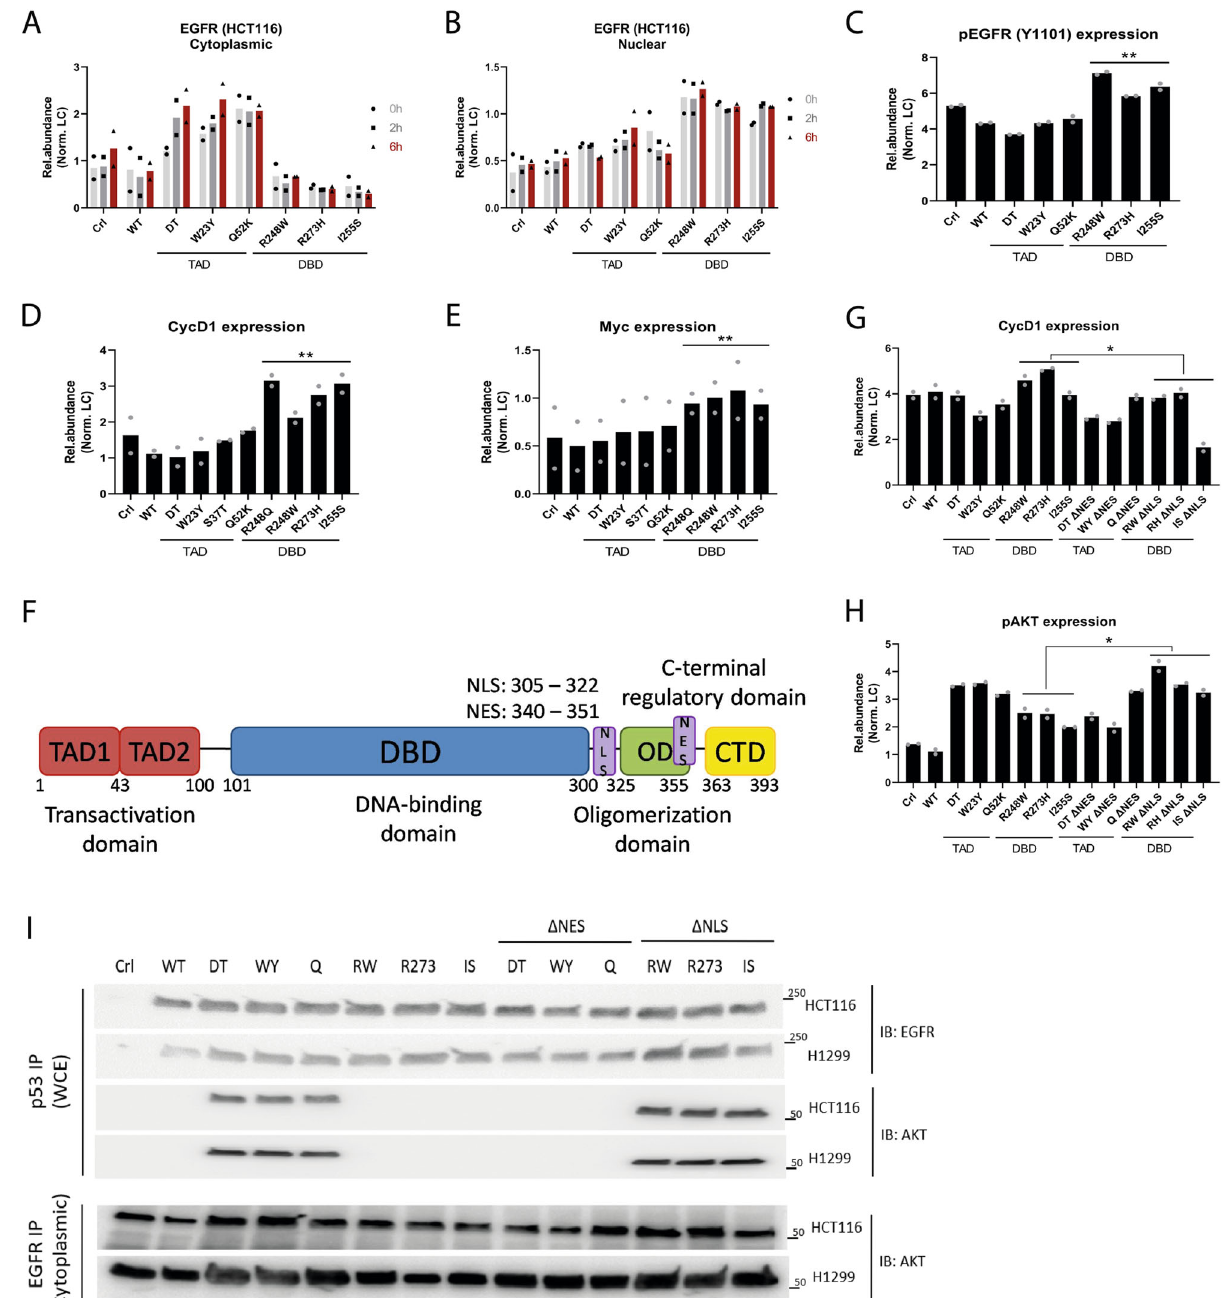
Fig.2|TADandDBDmutantp53stabilizeEGFRandpromotedifferentfacetsof EGFRfunction.A , B Quanti fi cationofEGFRproteinturnoverinHCT116 A cytosolic and B nuclear cellular fractions following treatment with cycloheximide. n =2. C – E Quanti fi cation of C pEGFR (Y1101), D Cyclin D1 and E c-Myc protein levels in HCT116 cells expressing WT and mutant p53. Statistical tests performed on TAD versus DBD. n =2. F Domain structure of p53 with nuclear localization (NLS) and export signal (NES) residues indicated. G , H Quanti fi cation of G Cyclin D1